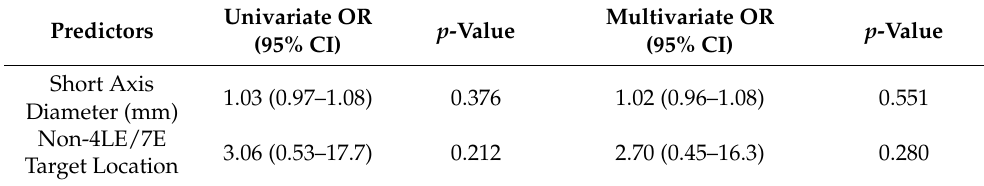
Table 4. Predictors of high EUSAT score (EUSAT >